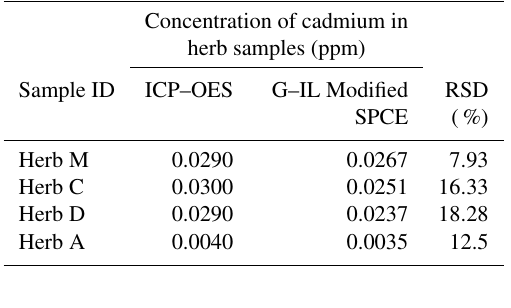
Table 3. Determination of mean concentration of cadmium in herb samples using both the ICP–OES and optimized electrochemical sensor with a G–IL modified SPCE. There were no significant dif- ferences in the variation of cadmium concentration detected by each detection technique, while the results from the two detection meth- ods differed from each other to some extent.